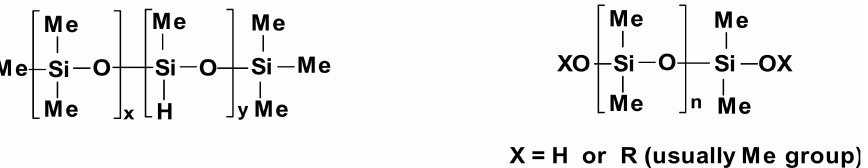
Figure 3. Chemical structures of reactive polysiloxanes [polymethylhydrosiloxanes (PMHS), and